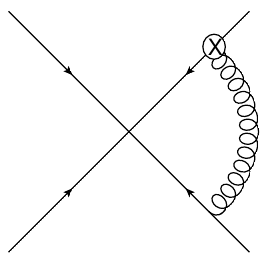
Figure 3 . Counterterm graph for the mushroom diagram of figure 2 ( a ) , where ⊗ denotes the counterterm for the gluon emission vertex from the Wilson